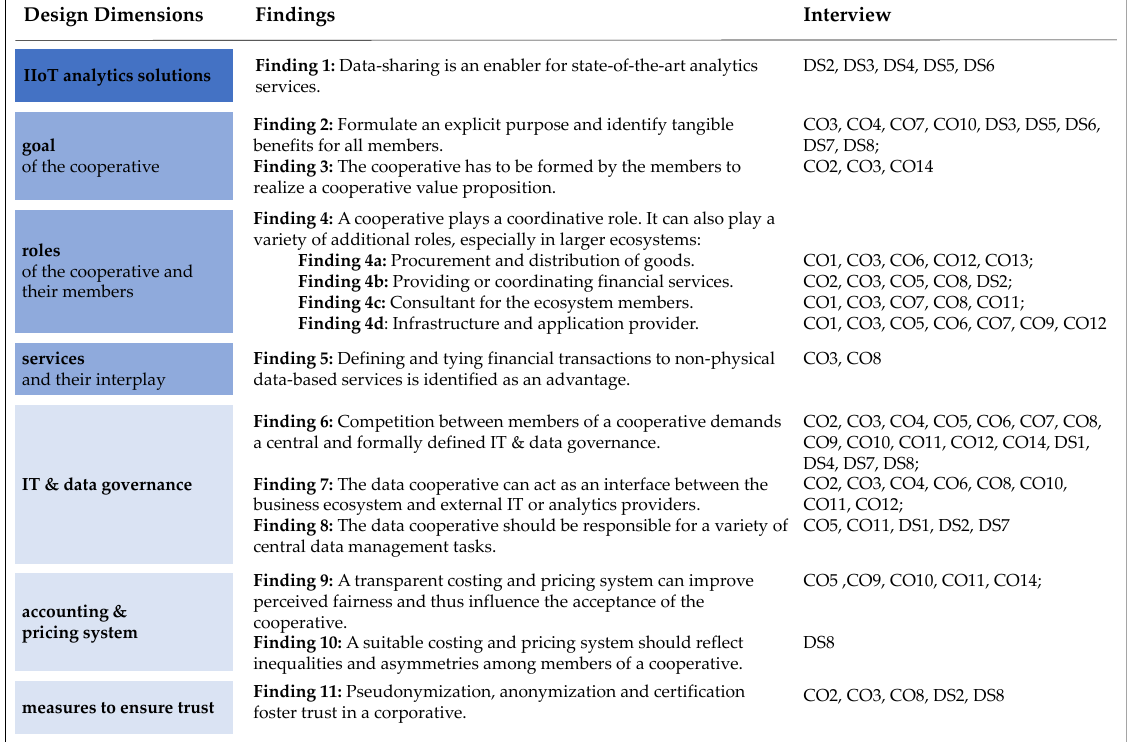
Figure 6. Summary of the findings.